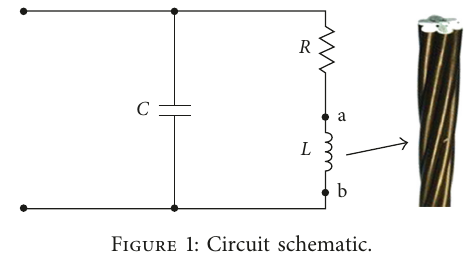
Figure 1: Circuit schematic.